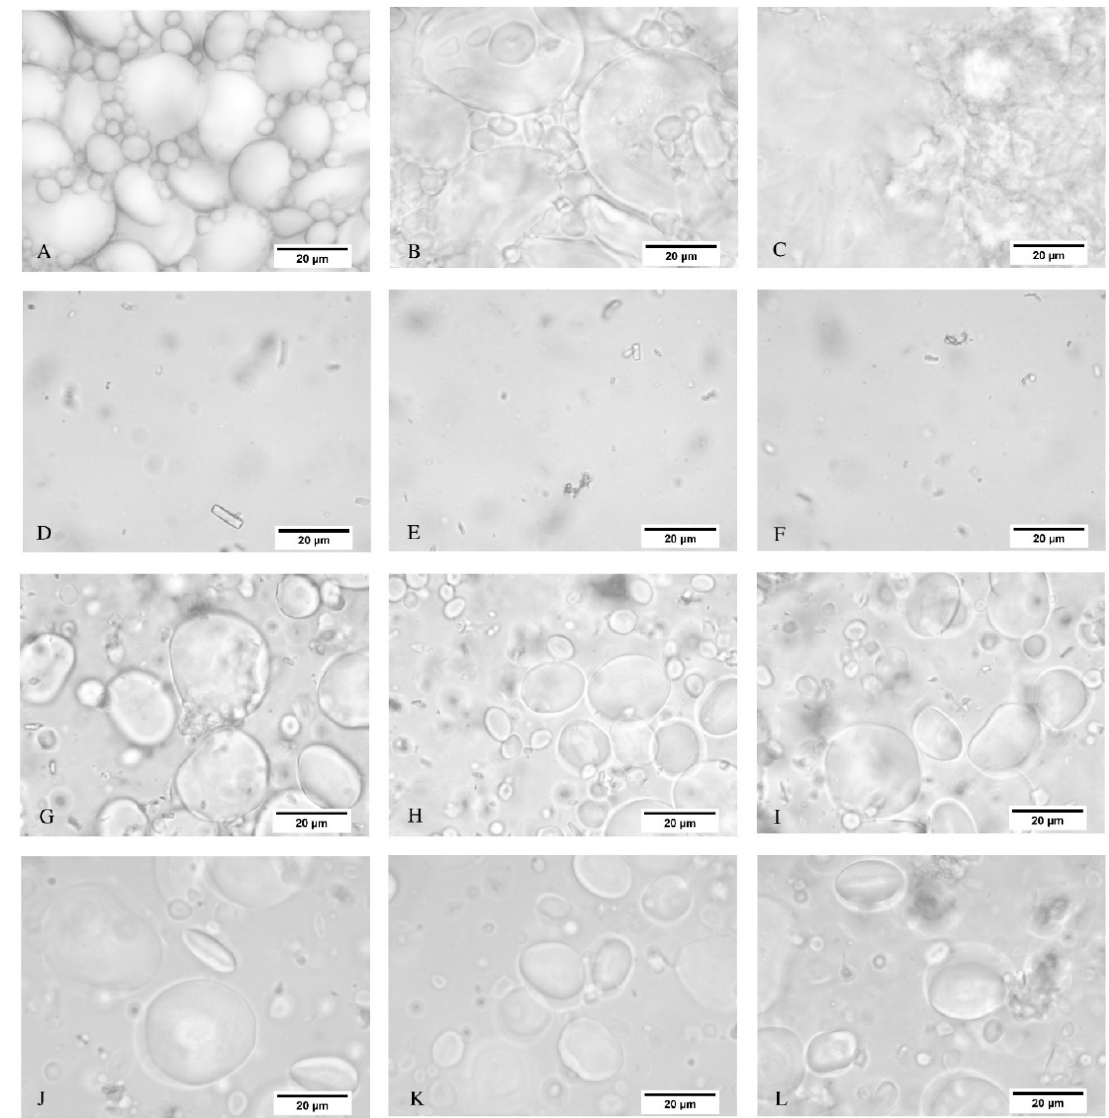
Figure 3. Light microscopy images of the wheat flour (WF) dispersion at room temperature ( A ) and after being heated for 2 min ( B ), and for about 15 min at 94 °C ( C ); TSSL at room temperature ( D – F ); TSSL+WF-RT binder at room temperature ( G – I ); and TSSL+WF-94 binder at room temperature ( J – L ). Scale bar: 20 µm.